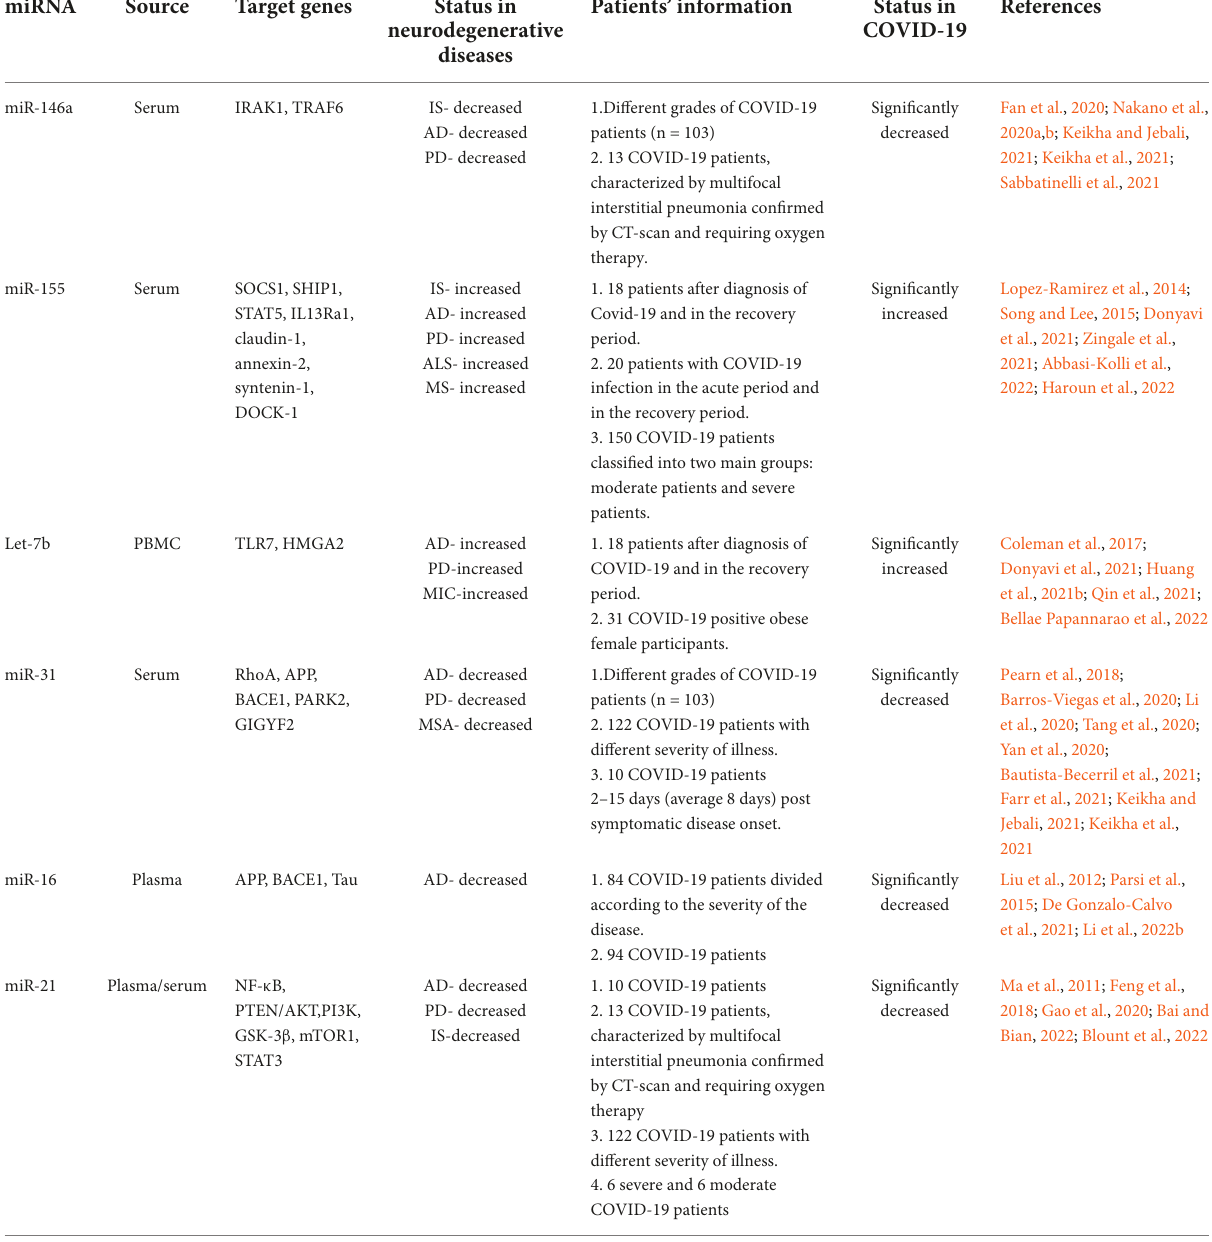
TABLE 2 Summary of circulating miRNAs associated with neurological dysfunction showing potential dysregulation in COVID-19.